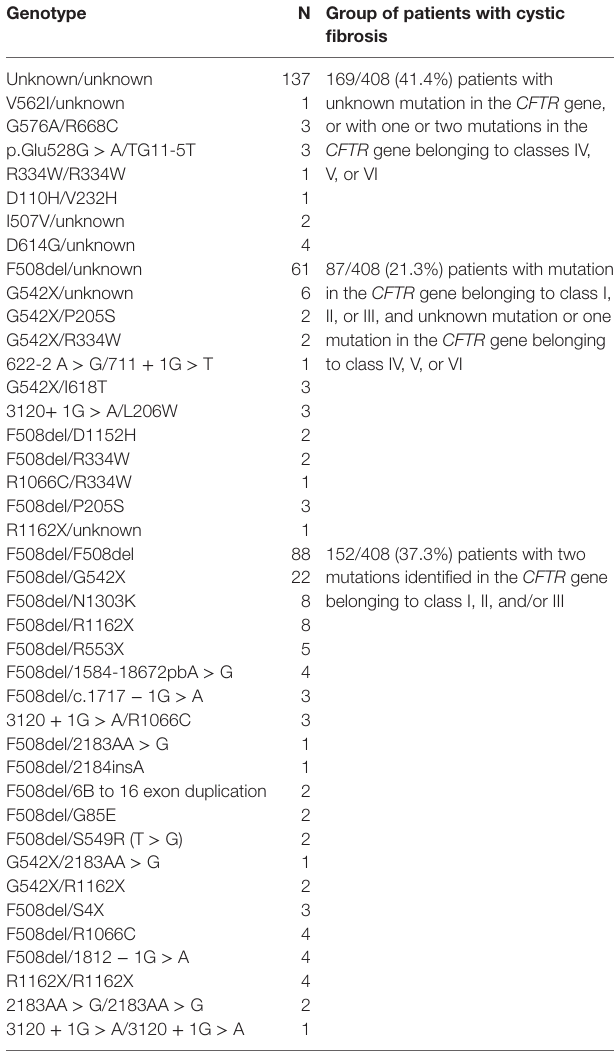
Table 4 | Association between immunoreactive trypsinogen (IRT) inclusion in our center and subject’s sex and age and cystic fibrosis diagnosis. chloride levels